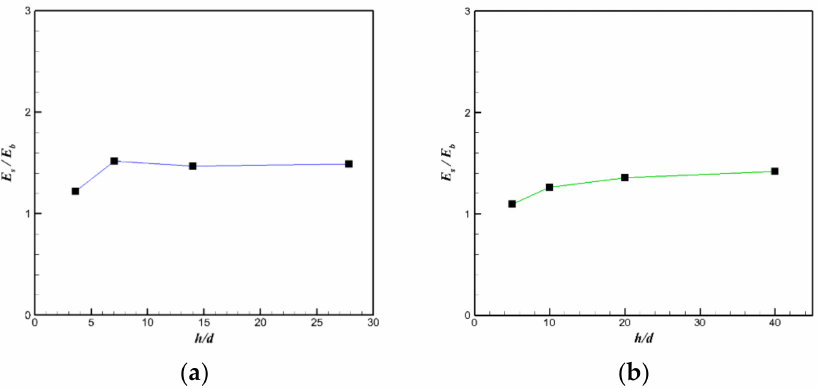
Figure 9. Effect of relative particle size on the simulated Young’s modulus: ( a ) three-point bending test; ( b ) uniaxial compressive test.